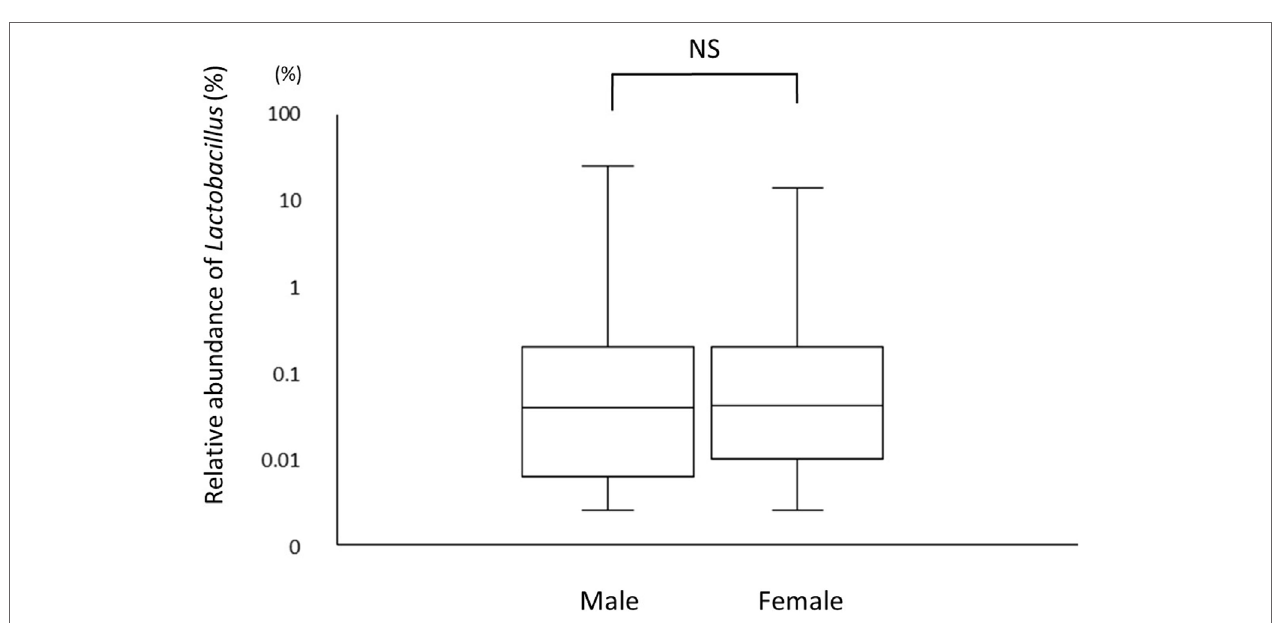
FigUre 2 | The relative abundance of the Lactobacillus in gut microbiota among Helicobacter pylori non-infected subjects and infected subjects with different degree of atrophic